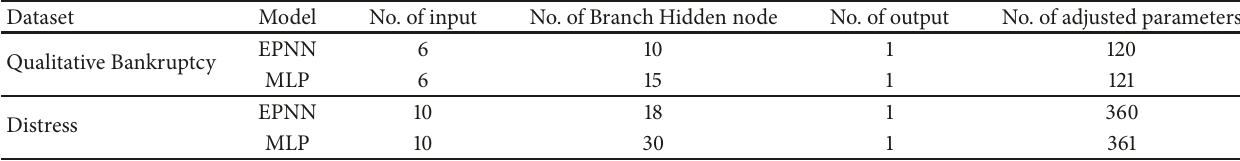
Table 6: Structures of EPNN and MLP for the Qualitative Bankruptcy and Distress data set.